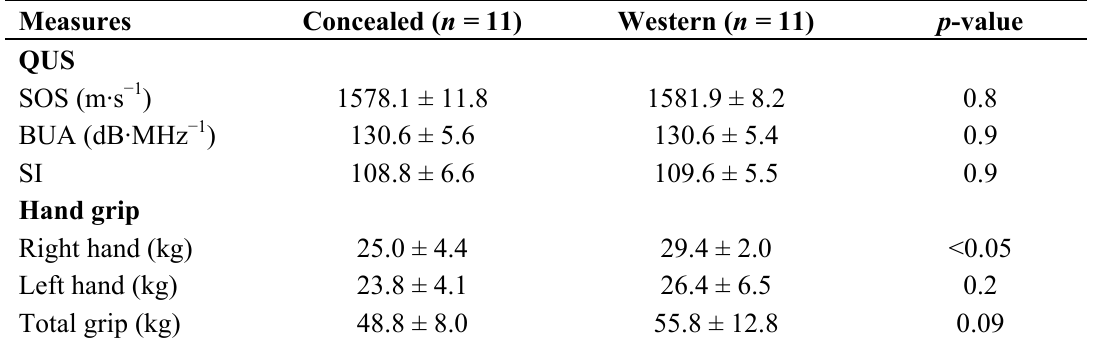
Table 2. Bone and muscle strength of women who wore concealing versus western-style clothing.